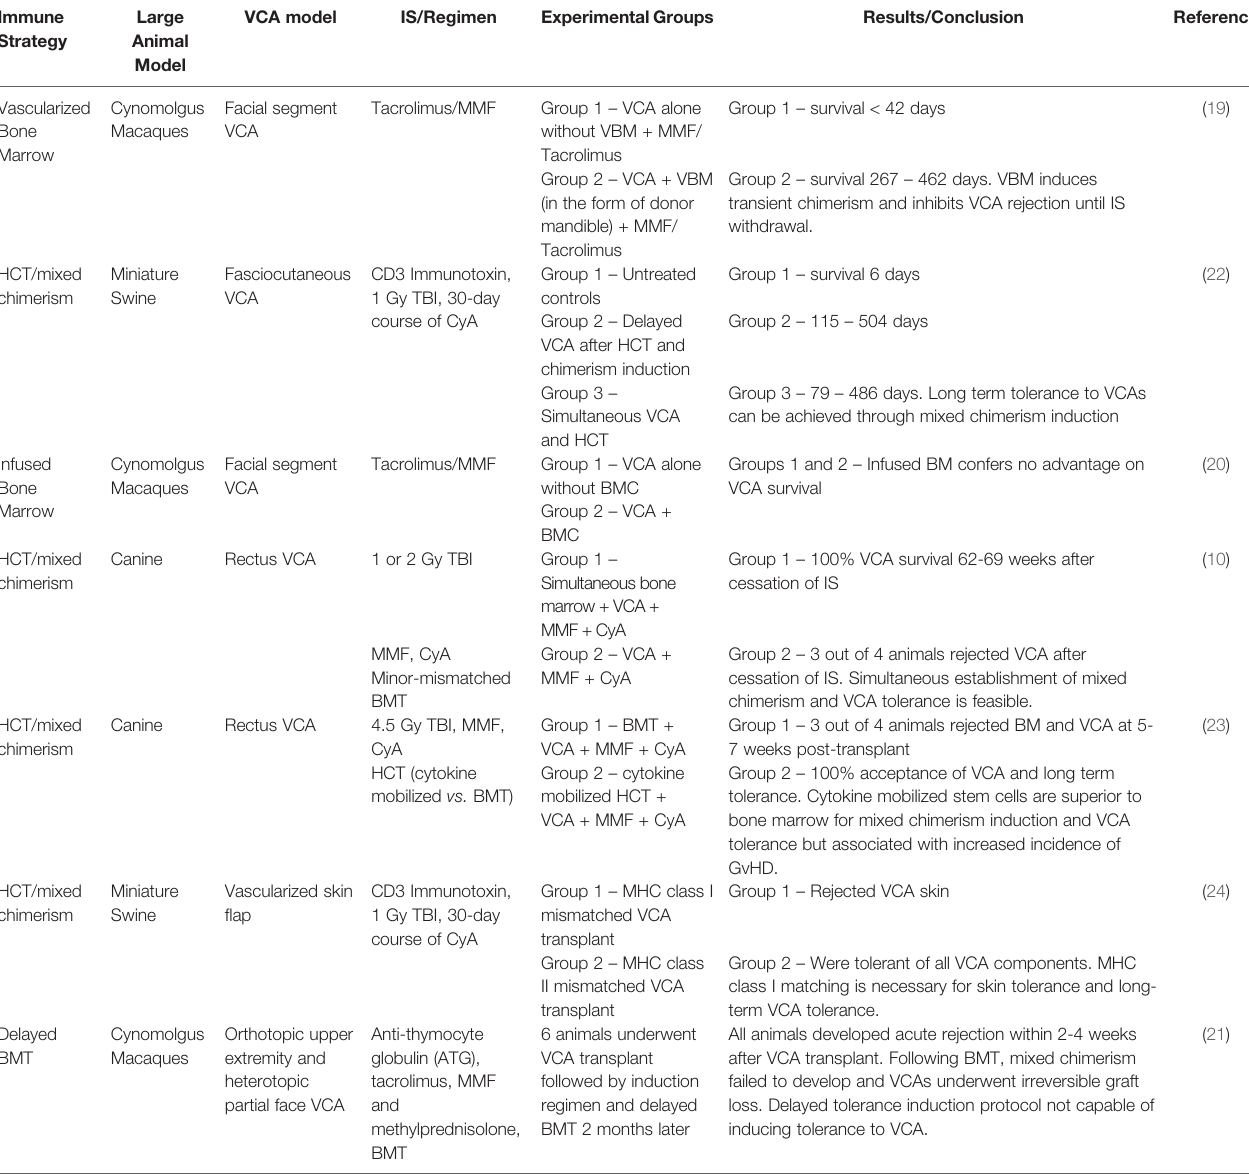
TABLE 1 | Bone marrow and hematopoietic cell